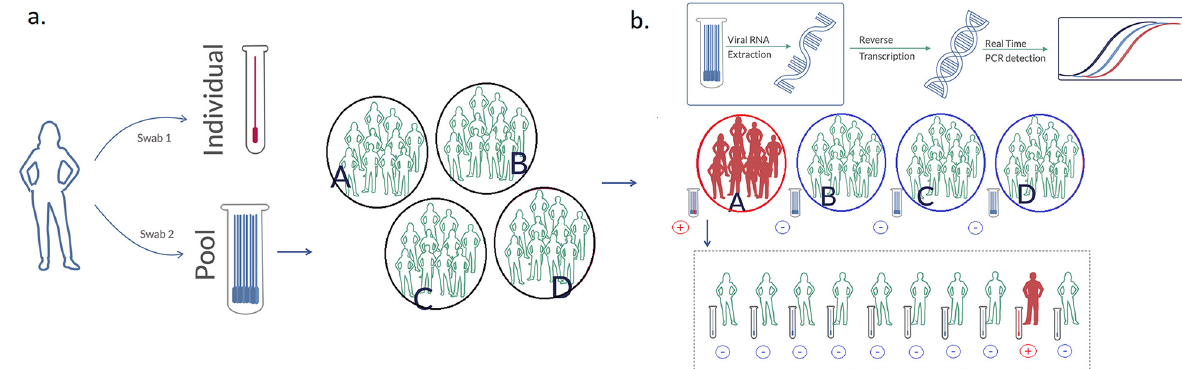
Figure 1. Pooled RT-qPCR strategy scheme, 1a. Two nasopharyngeal-swabs were collected from each patient. The first swab was pooled together with nasopharyngeal_swabs from up to 10 individuals and the second was stored separately. 1b. RT-qPCR was conducted with the pooled swabs, and whenever a pool displayed a positive result, individual swabs from each patient from that pool were analyzed to identify the infected individuals. Illustration adapted from Christoff et al.